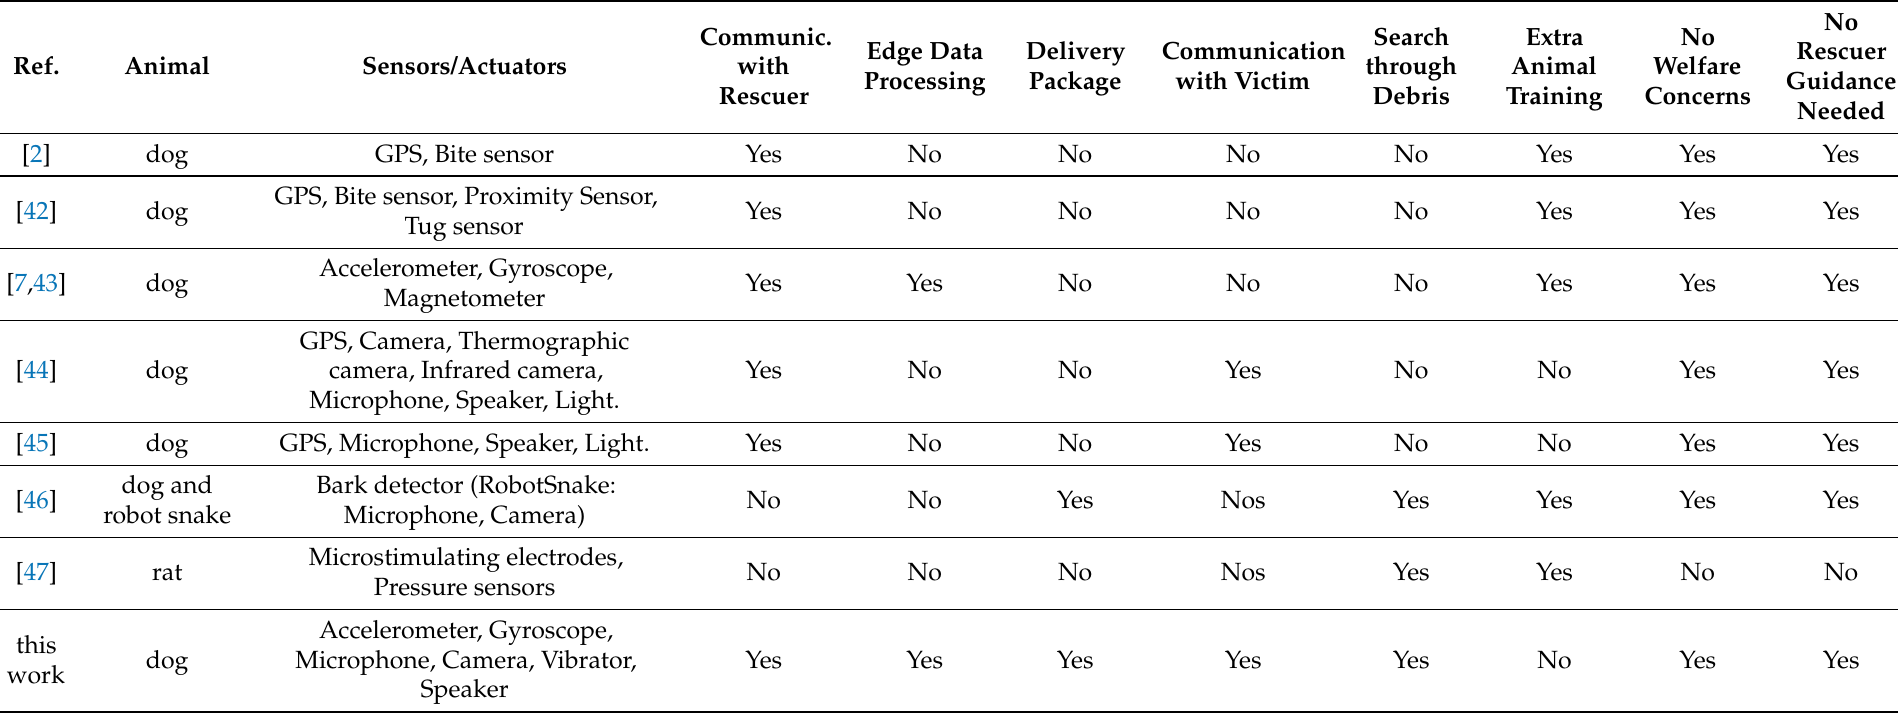
Table 2. Summary of the existing SaR solutions based on animal wearables.